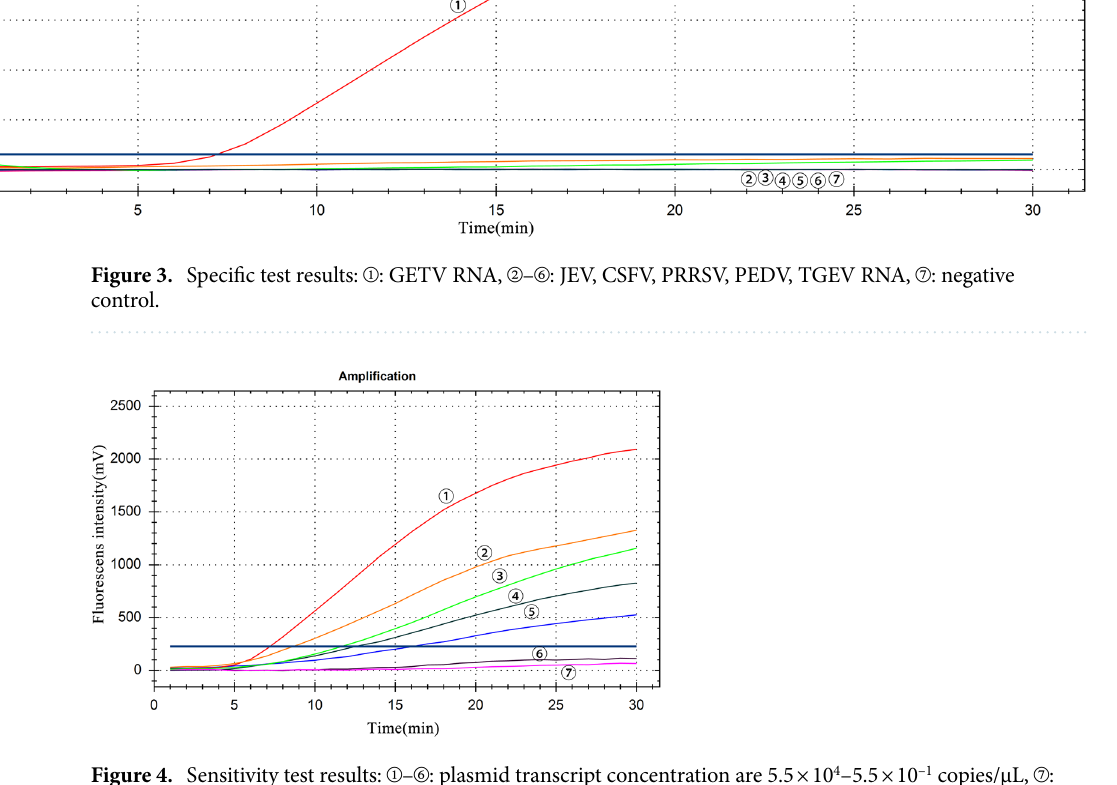
Figure 4. Sensitivity test results: ① – ⑥ : plasmid transcript concentration are 5.5 × 10 4 –5.5 × 10 –1 copies/μL, ⑦ : negative control.